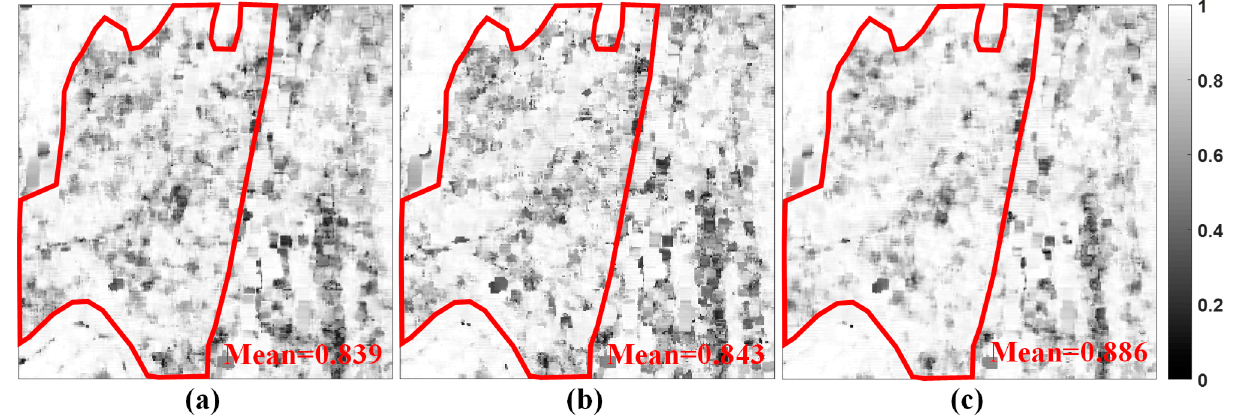
Figure 12. Estimated TPC images of ROI (250 × 250 pixels) using ( a ) HH, ( b ) ESPO, and ( c ) proposed TSTP methods. The estimated TPC means over the natural scene are shown in Figure 12. The lowly coherent natural area is marked by the red irregular box in Figure 12a–c.